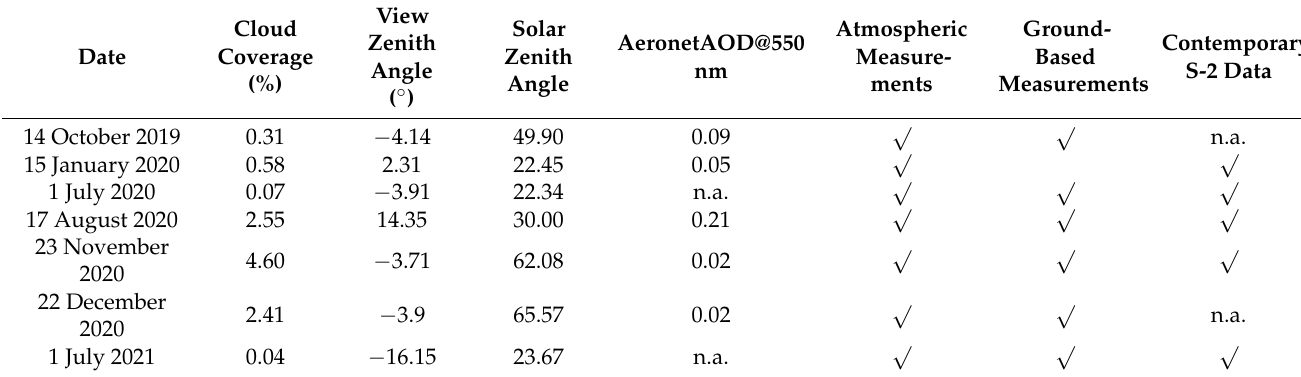
Table 2. PRISMA acquisitions for the Pignola test site (Italy).